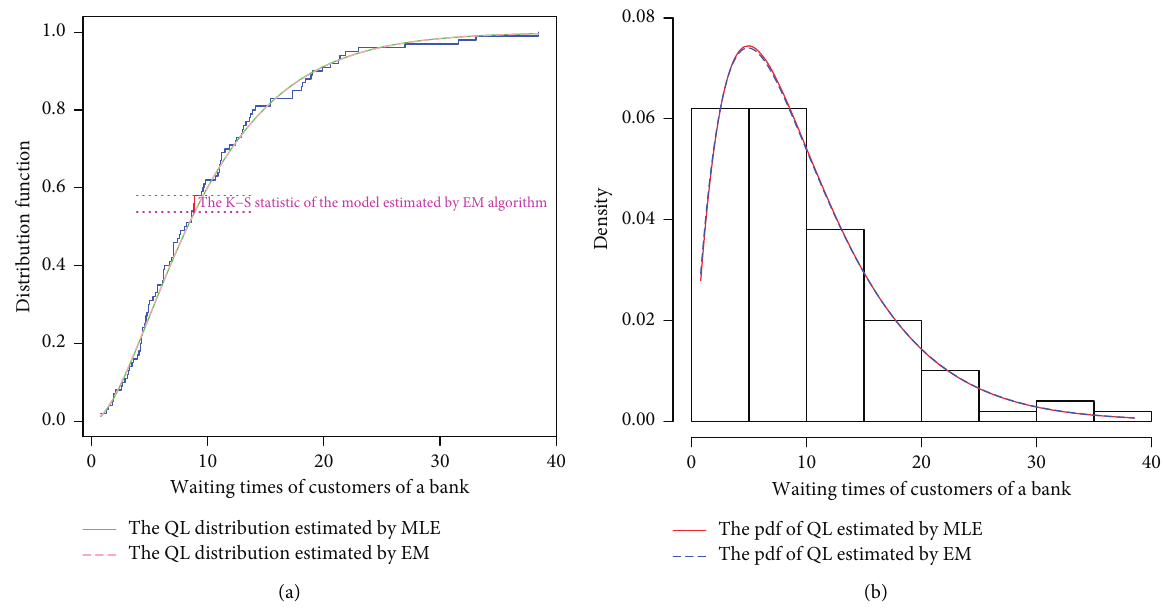
Figure 1: (a) The empirical distribution and fitted quasi-Lindley distribution for dataset of Table 3. (b) The histogram and the estimated probability density function for this